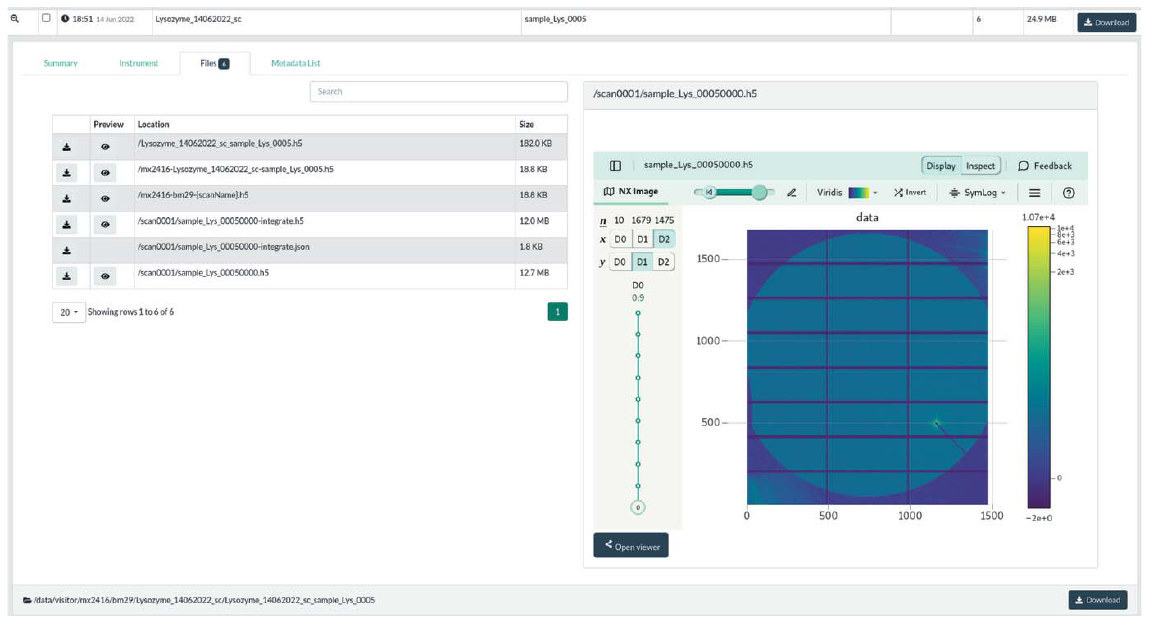
Figure 3 The default visualization offered by the ESRF data portal (https://data.esrf.fr) of a stack of frames acquired at the BioSAXS beamline, using the h5web viewer.